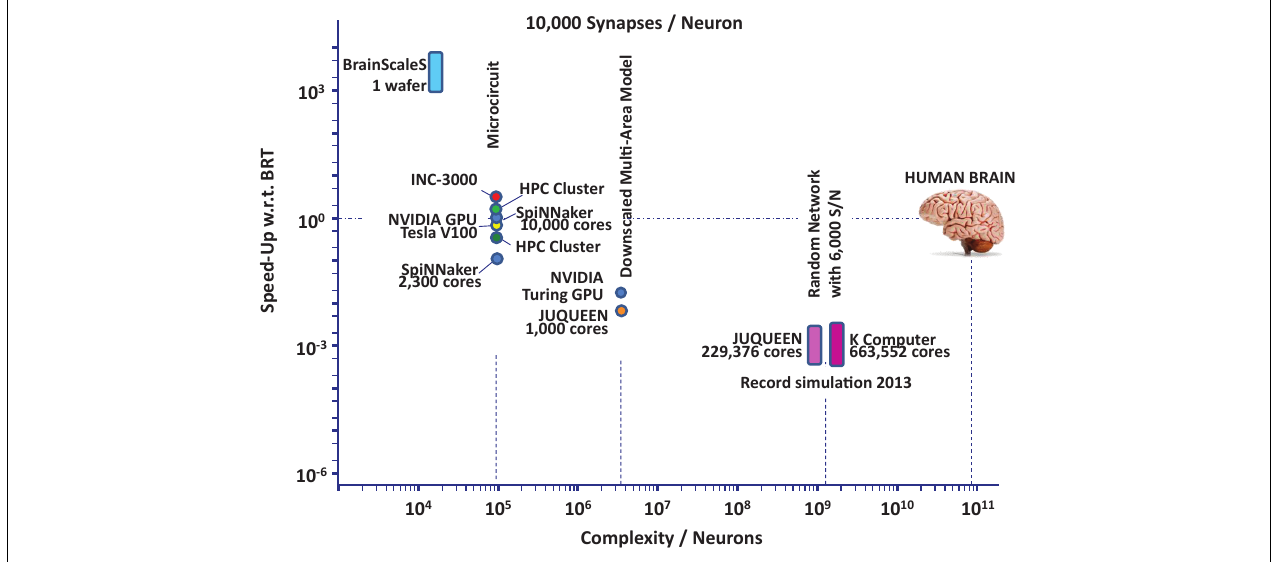
FIGURE 1 | State-of-the-art performance trends based on data found in RIKEN BSI (2013), Schmitt et al. (2017), Knight and Nowotny (2018, 2021), Kurth et al. (2020), Rhodes et al. (2020), van Albada et al. (2021) for neuroscience simulation platforms: speed-up in units of biological realtime (BRT) vs. network complexity in units of neurons assuming essentially random